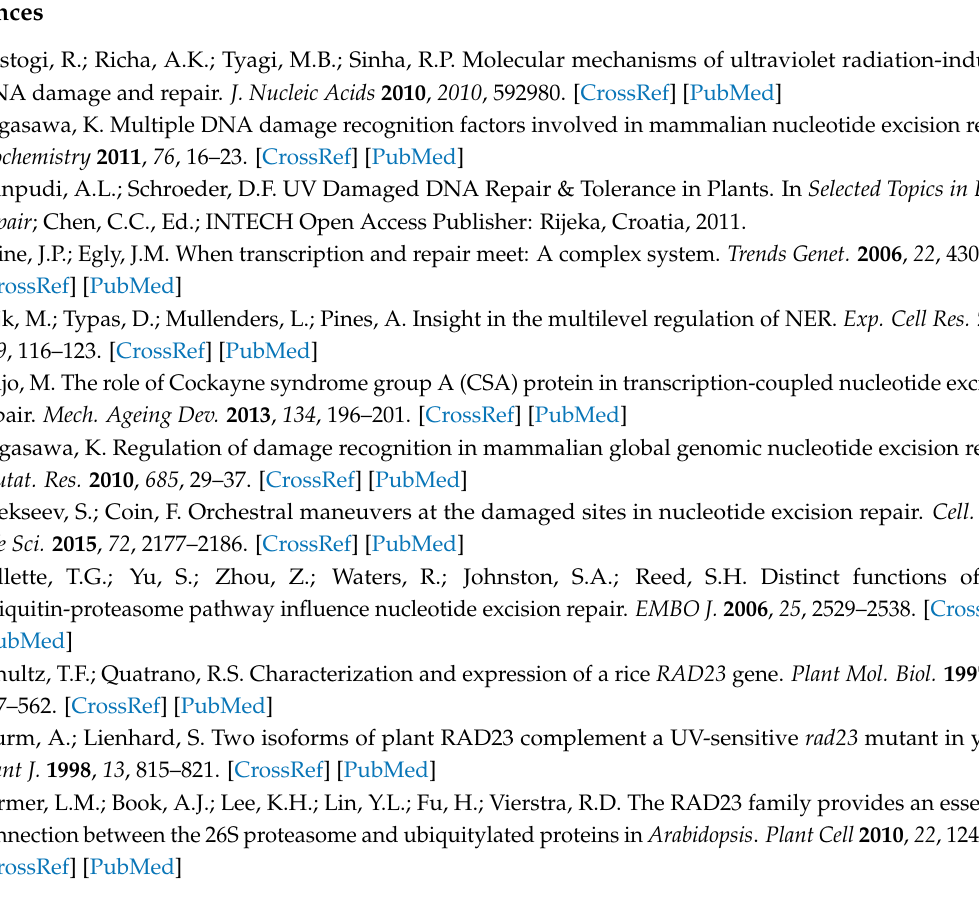
Figure S3: Yeast two-hybrid analysis of RAD4 self-interaction. Figure S4: Yeast two-hybrid analysis of RAD4–RAD23B